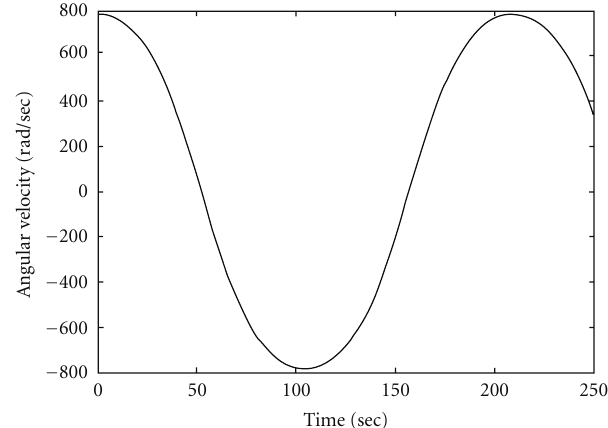
Figure 12: Plot of angular velocity (rad/second) versus time (second) for sinusoidal motion of leader.